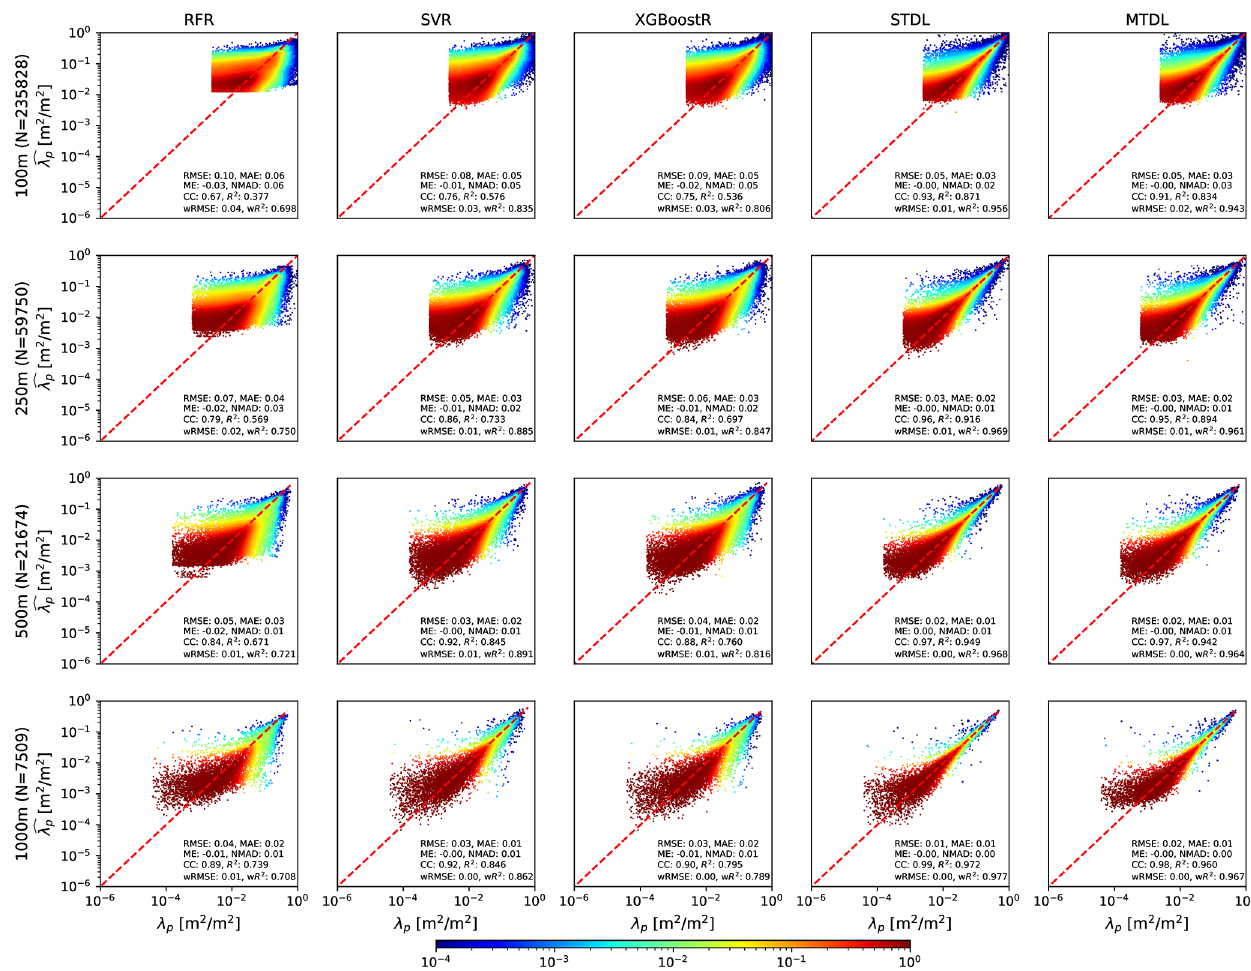
Figure 5. λ p predicted by ML models and DL models. The density of scatter points is normalized to [10 − 4 , 1] and represented using shading colours. The presented evaluation metrics are calculated based on the reference values from D test , 2 which consists of samples from 43 cities by patch-level sampling (See Sect. 2.2.3 for